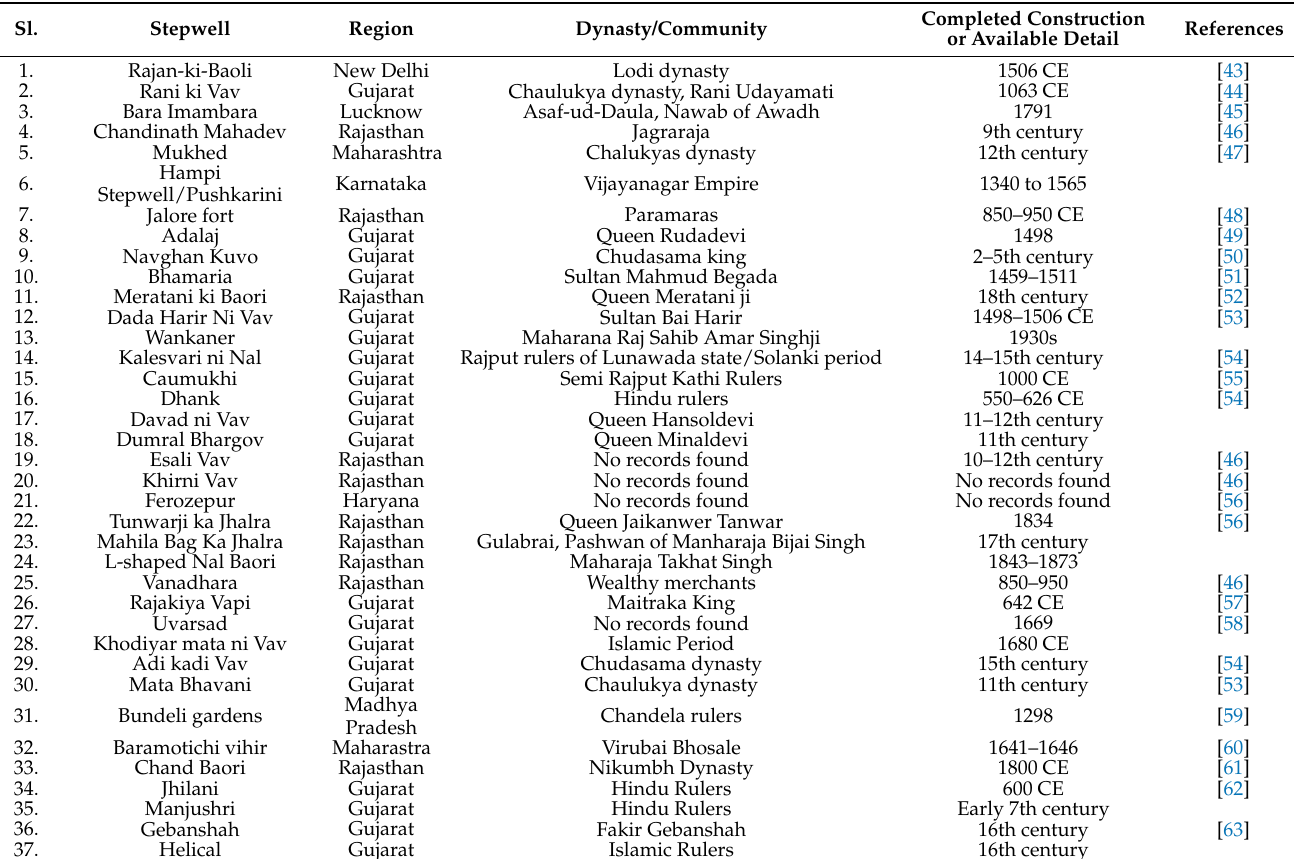
Table 1. List of Major stepwells in India constructed under different